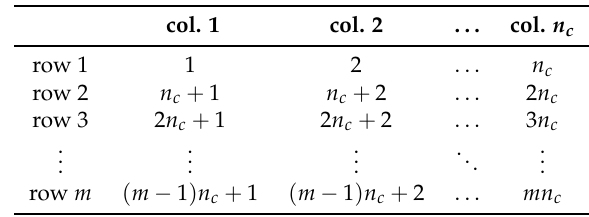
Table 1. Order of the WDT